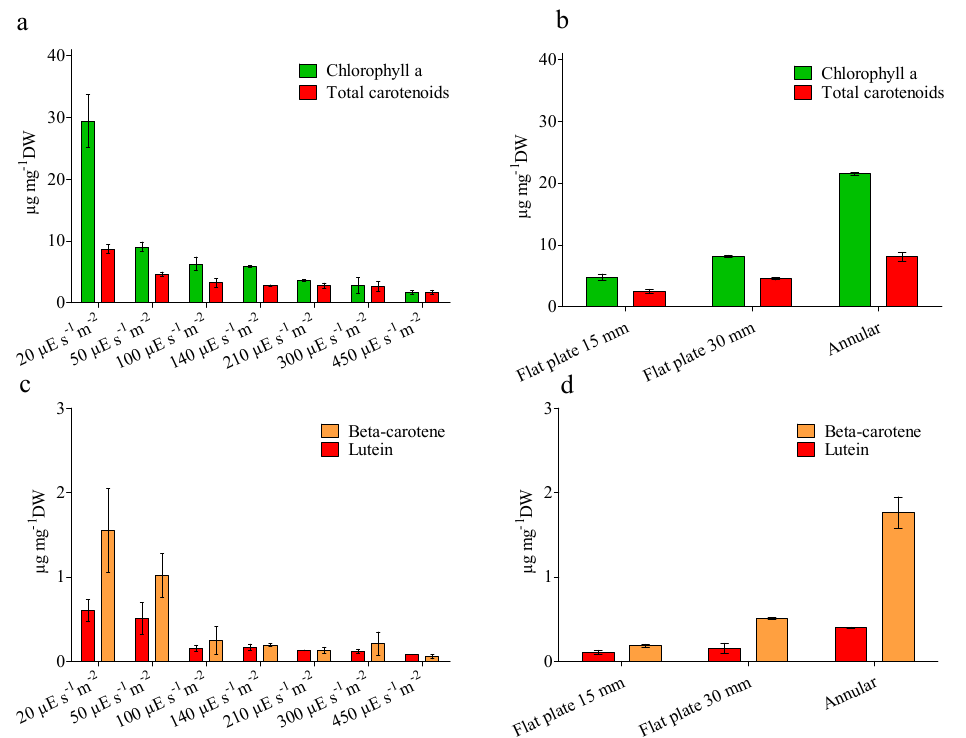
Figure 10. Carotenoid analysis of the biomass obtained at the end of the batch cultivations grown under different conditions: ( a , c ), quasi-isoactinic reactor with different photon flux densities; ( b , d ), reactors with different configurations at incident light intensity I 0 = 210 µE s − 1 m − 2 . DW: dry weight.